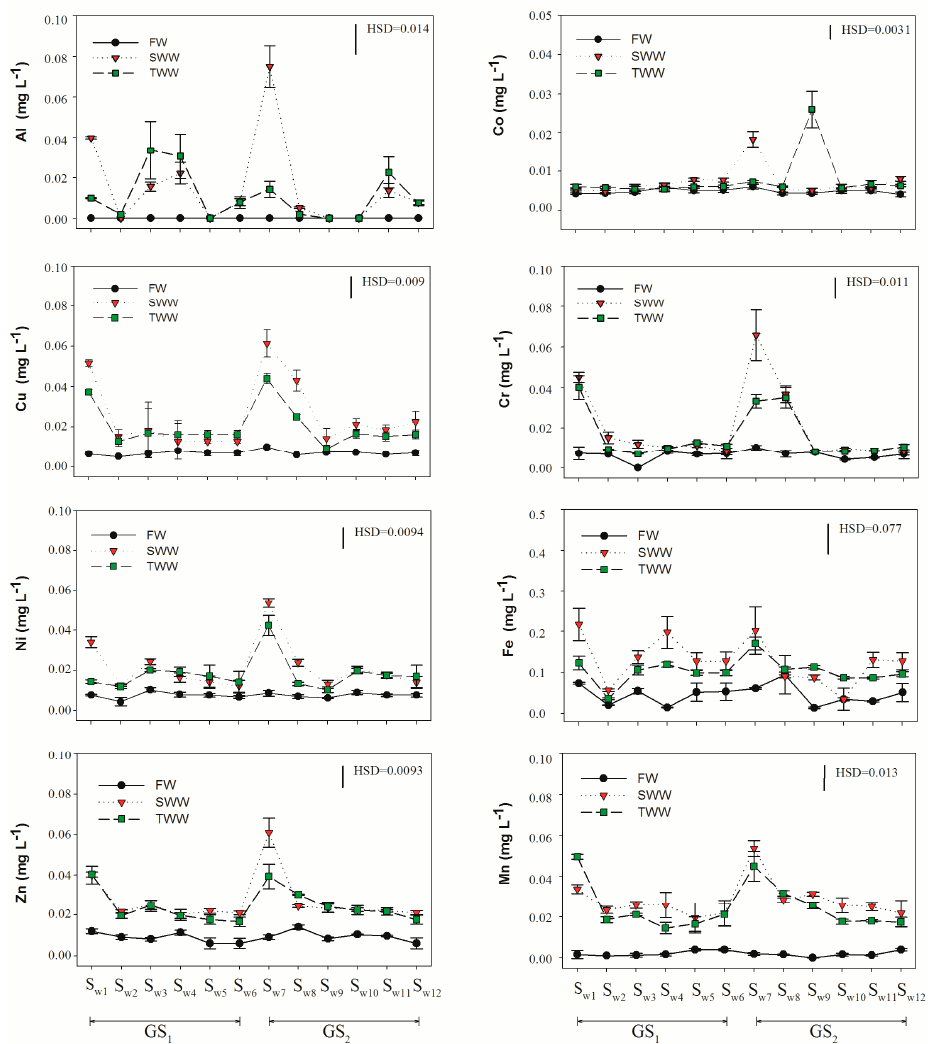
Figure 1. Heavy metal contents of the three irrigation water types applied as function of water sampling date, showing the irrigation water × water sample date interaction (IW × S W ). The data are the means ± standard errors of three replicates. GS 1 , first growing season; GS 2 , second growing season. S W1 –S W12 are the water sampling dates for the first (S W1 –S W6 ) and second (S W7 –S W12 ) growing seasons. Honest significant differences (HSDs) calculated according to Tukey’s test are also